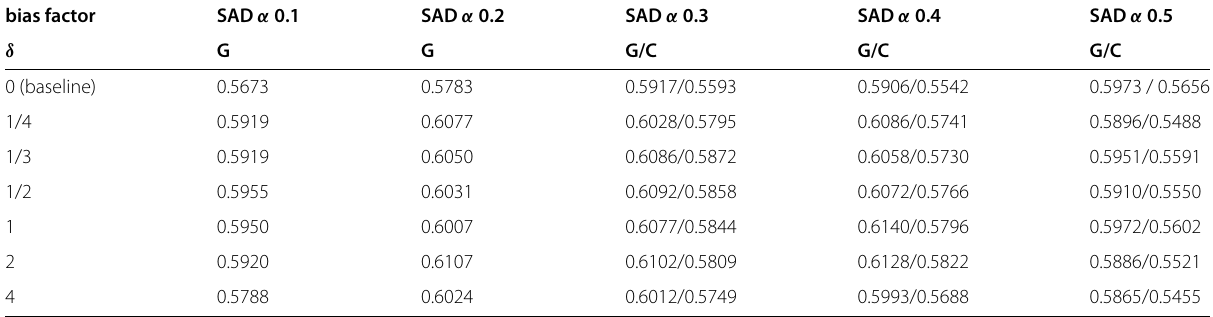
Table 8 A comparison of using different bias factors and SAD dilation-erosion factors on ASR Model 1. ATWV values are evaluated on the SAD segmented dev dataset. “G” and “C” represent GMM-HMM aligner and CTC aligner, respectively